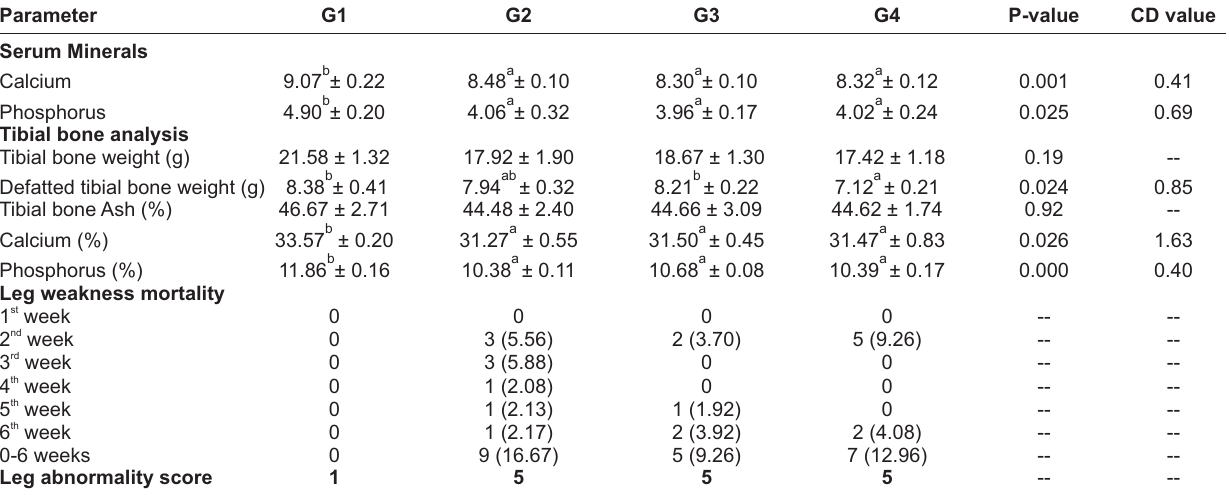
Table-3: Influence of Coenzyme Q10 at two levels on the tibial bone, production score, leg weakness and leg abnormality score of broilers